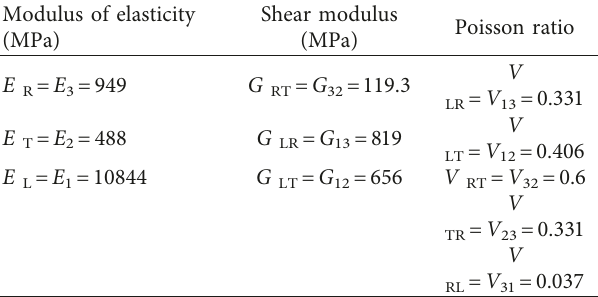
Table 1: Glulam brace mechanical property